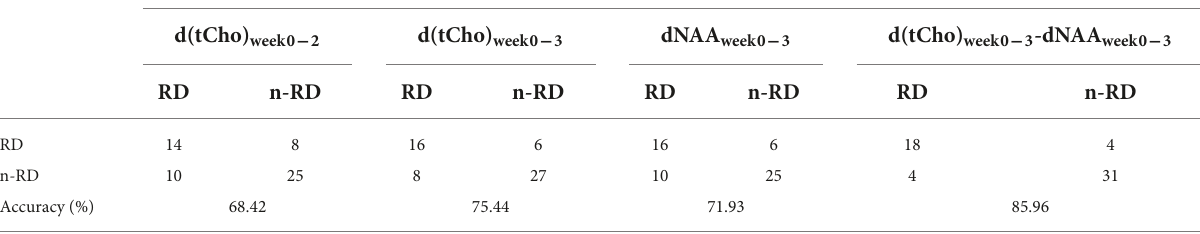
TABLE 3 Diagnosis accuracy of the MRS metabolites